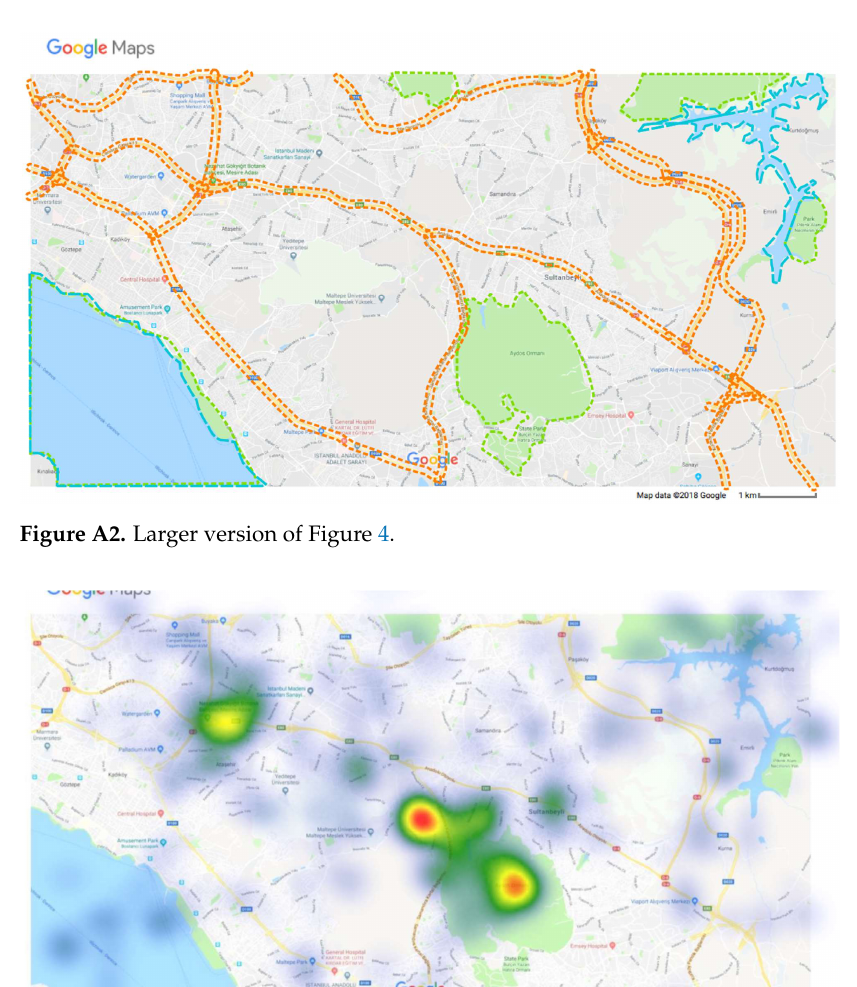
Figure A3. Larger version of Figure 8a. ISPRS Int. J. Geo-Inf. 2023 , 11 , x FOR PEER REVIEW